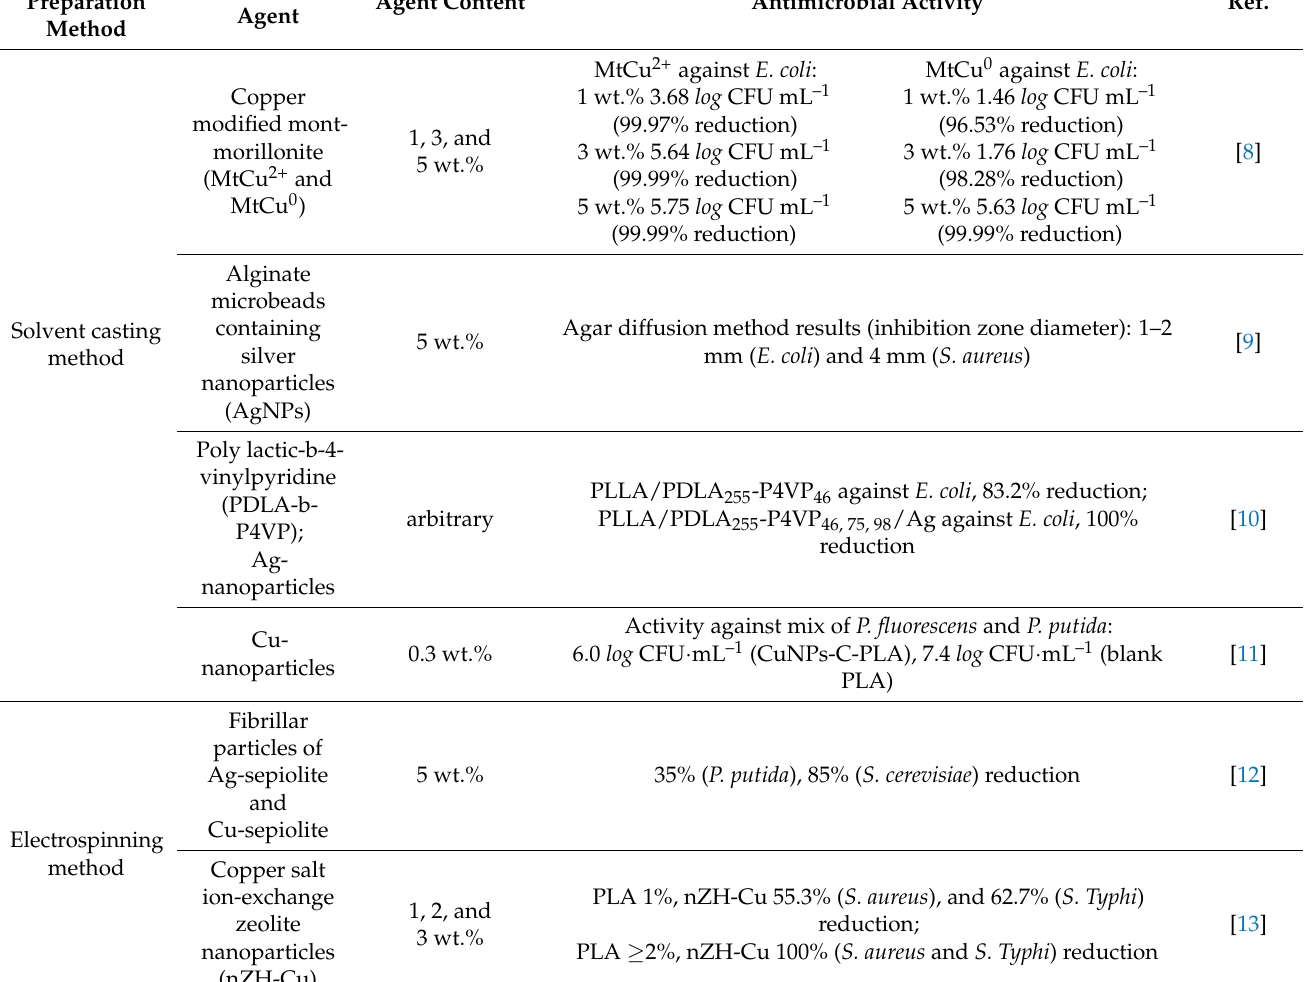
Antimicrobial Activity